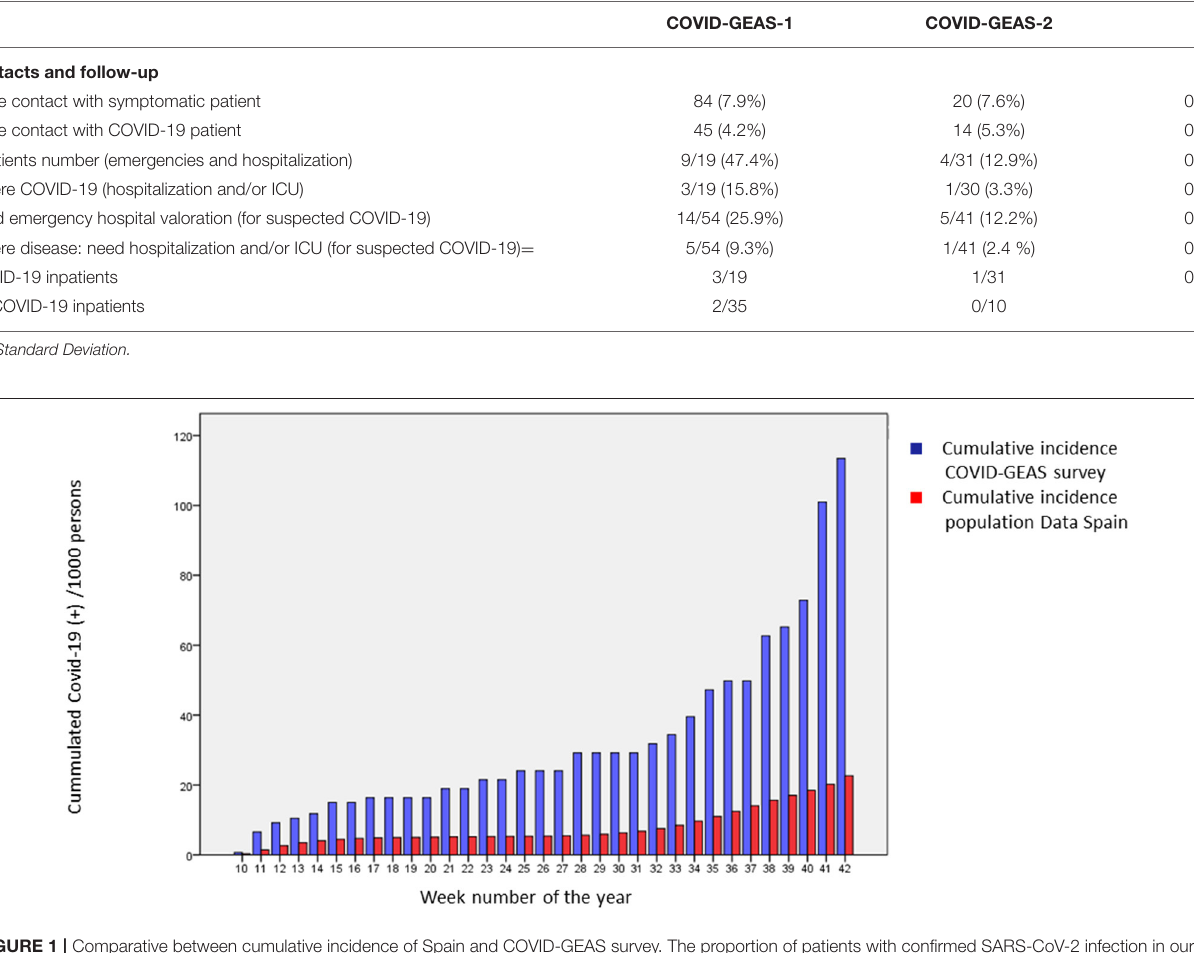
one vasculitis (5.88%). A total of 10 (58.8%) patients were